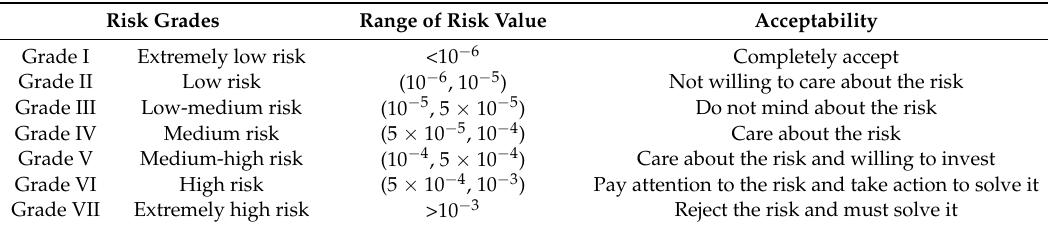
Table 1. Levels and values of assessment